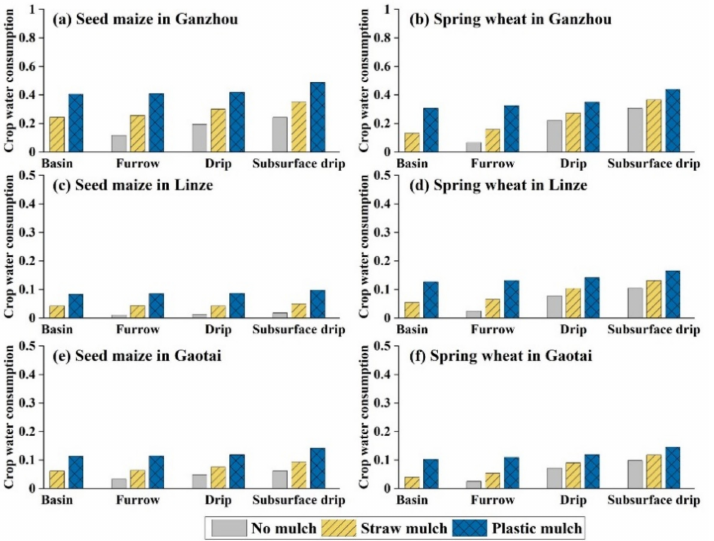
Figure 8. Reduction in crop water consumption (10 8 m 3 ) of seed maize in ( a ) Ganzhou, ( c ) Linze and ( e ) Gaotai, and spring wheat in ( b ) Ganzhou, ( d ) Linze and ( f ) Gaotai under different combinations of practices compared with no mulch and basin